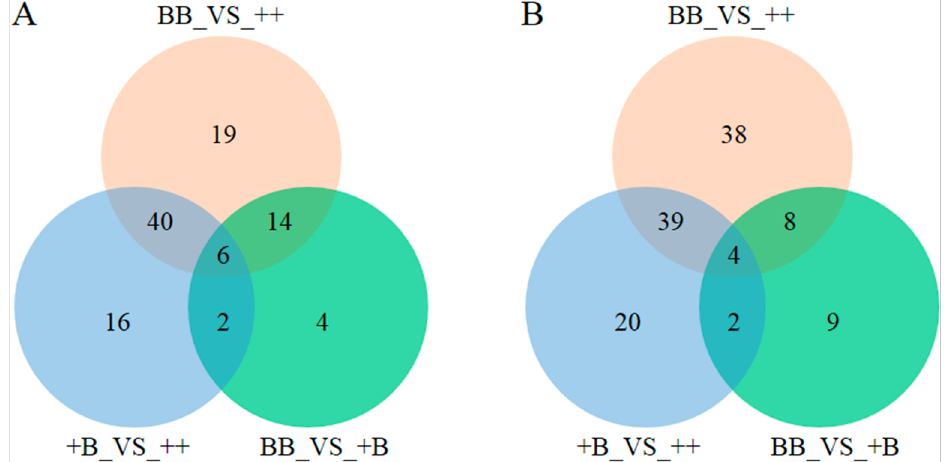
Figure 1. Venn diagrams for different levels of biochemical. ( A ) Venn diagrams for different levels of biochemicals in FF samples ( p ≤ 0.05); ( B ) Venn diagrams for different levels of biochemicals in OVS samples ( p ≤ 0.05).